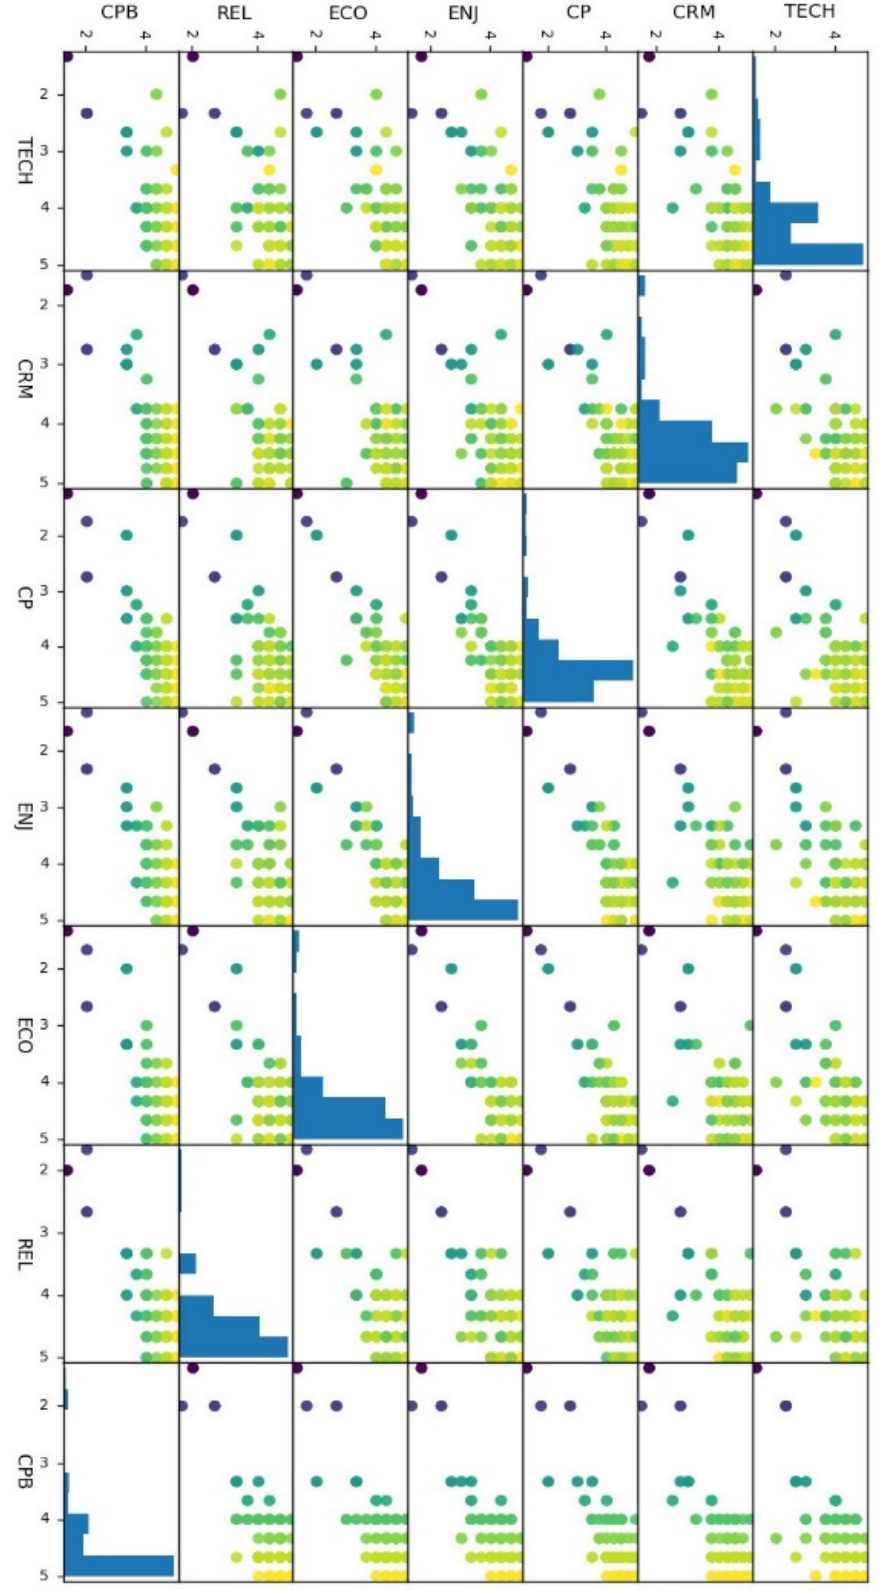
Figure 4. Exploratory data analysis, based on the seaborn package of Python. Table 7. Importance-performance map analysis.